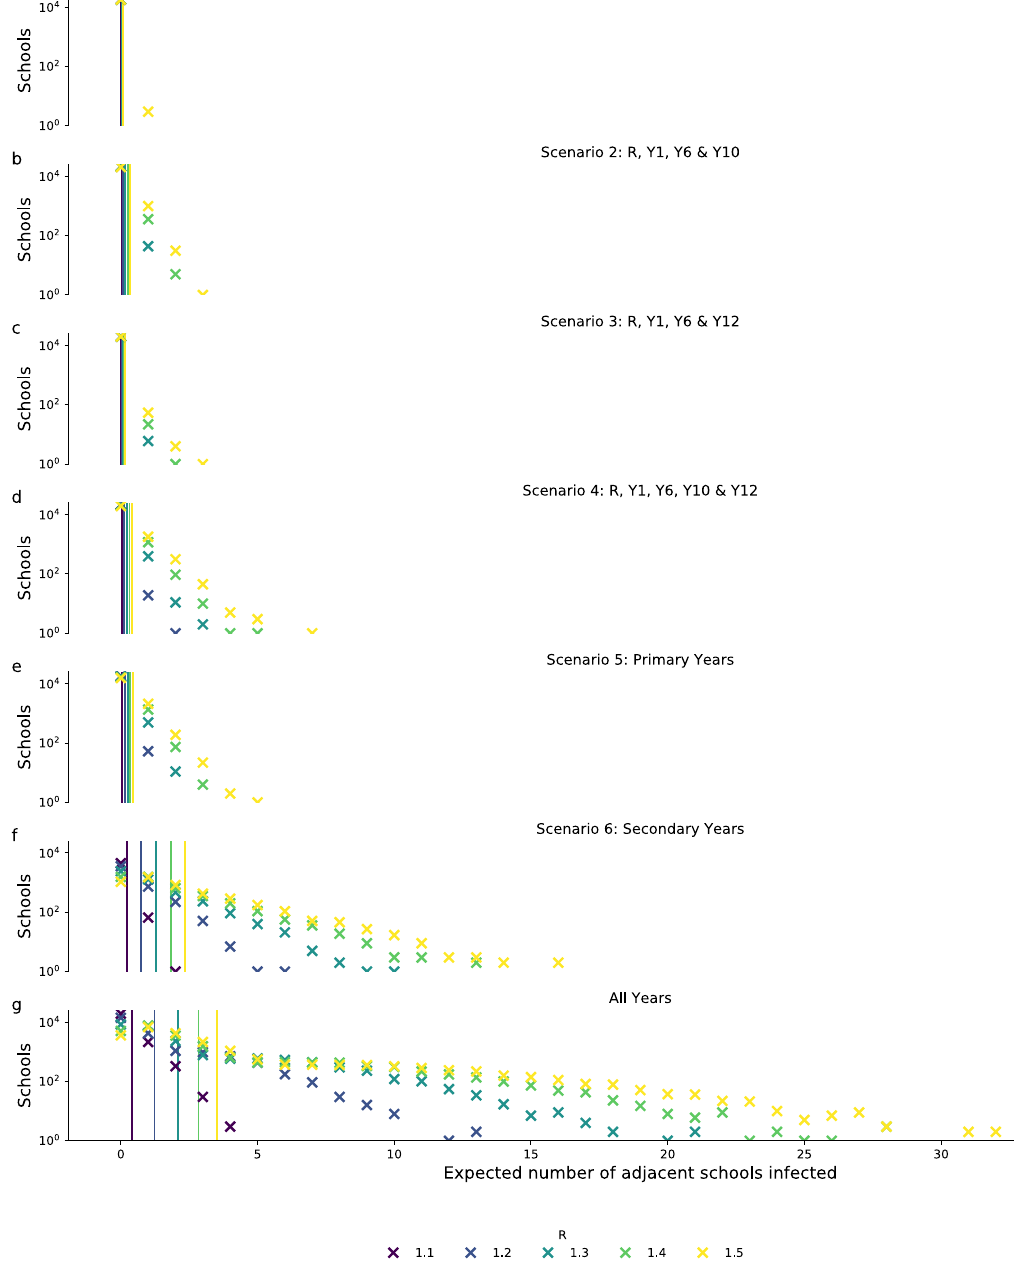
Fig. 3 The expected number of schools infected by each school. Weighted degree distribution of the transmission probability network for each of the reopening scenarios considered for R values of 1.1 – 1.5. Panels a – f show reopening scenarios 1 – 6, respectively, and panel g shows the network with all school years in attendance. Vertical lines show the mean degree for each value of R